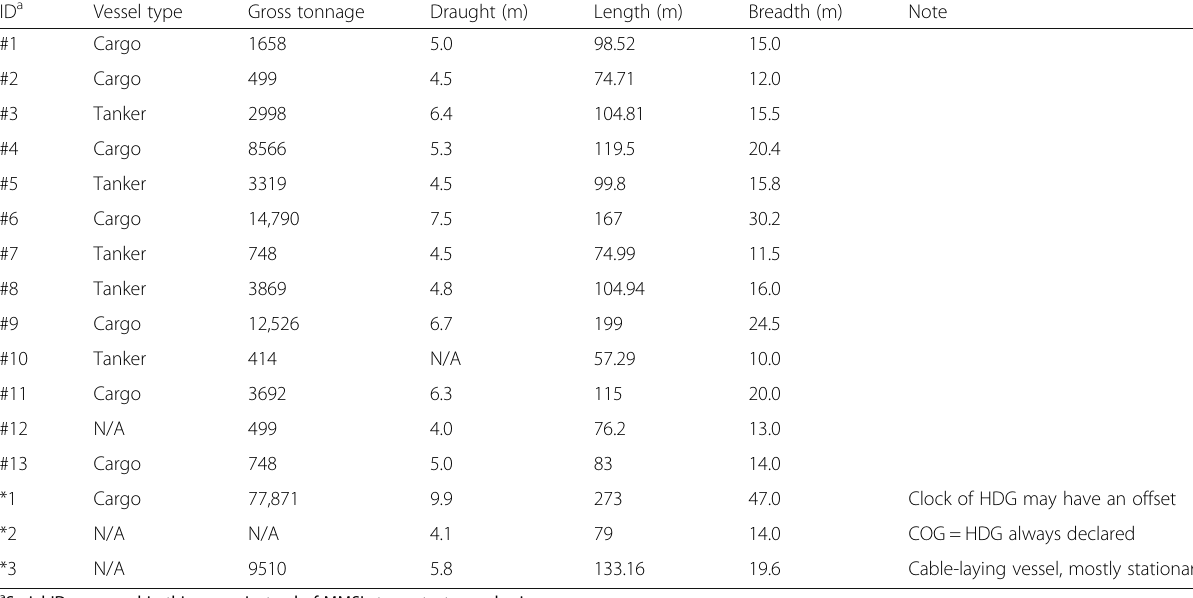
Table 1 Static information of vessels derived from AIS data, except for gross tonnage, which was taken from MarineTraffic (https://www.marinetraffic.com/)